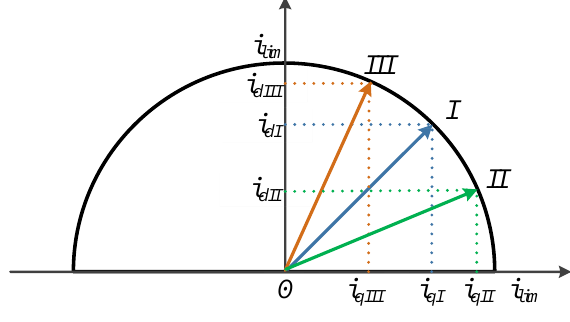
Figure 5. The different limiters of an MMC-HVDC.